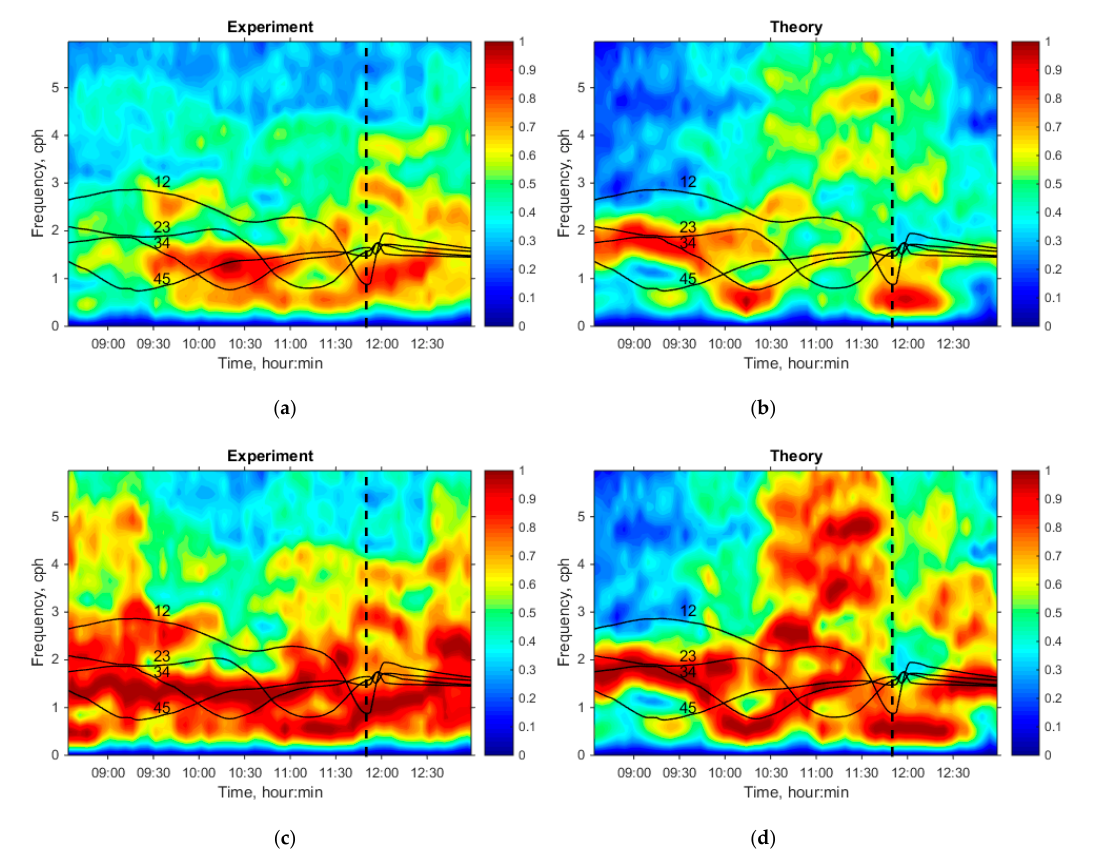
Figure 12. Comparison of experiment and theory. Normalization: ( a , b ) to the global maximum over the whole picture; ( c , d ) to a local maximum on each time moment. The dashed line is the time of passage of the soliton through the chain E2 (11:50). Black lines are dependencies F mn ( T ) .